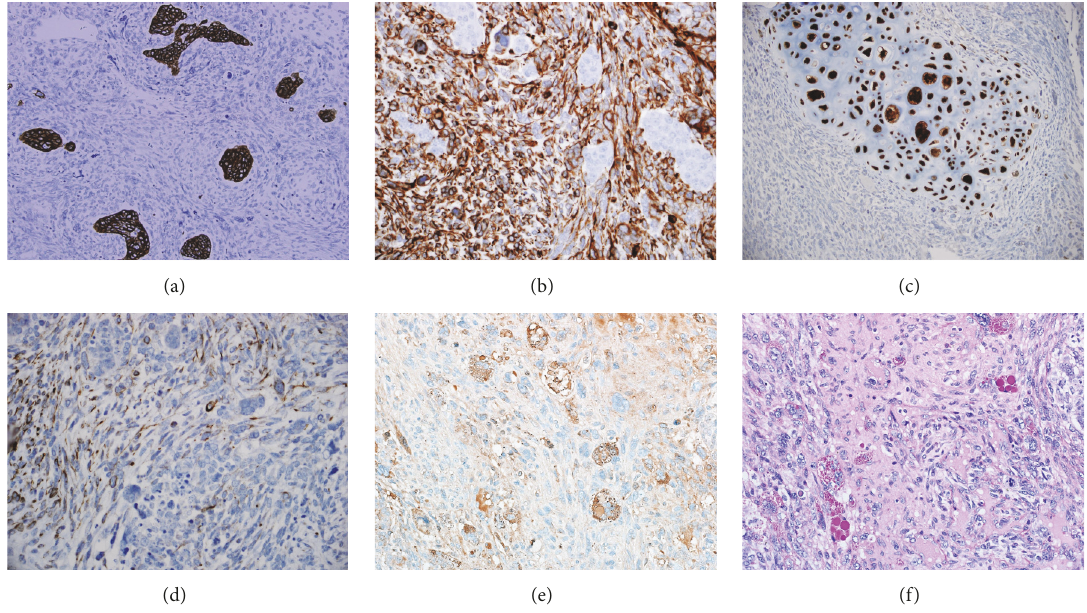
Figure 3: (a) Cytokeratin AE1/AE3 immunostain featuring positive nests of malignant epithelial cells and negative staining of sarcomatous component. X100. (b) Vimentin stain featuring positive staining of sarcomatous cells, and negative staining of epithelial nests. (c) Island of malignant cartilage staining positively for S100-protein X100. (d) Desmin stain featuring scattered positive mesenchymal sarcomatous cells. X200. (e) Alpha 1-antitrypsin positive staining of eosinophilic hyaline globules. X100. (f) Eosinophilic hyaline globules (EHGs) stain positive for PAS stain with diastase.